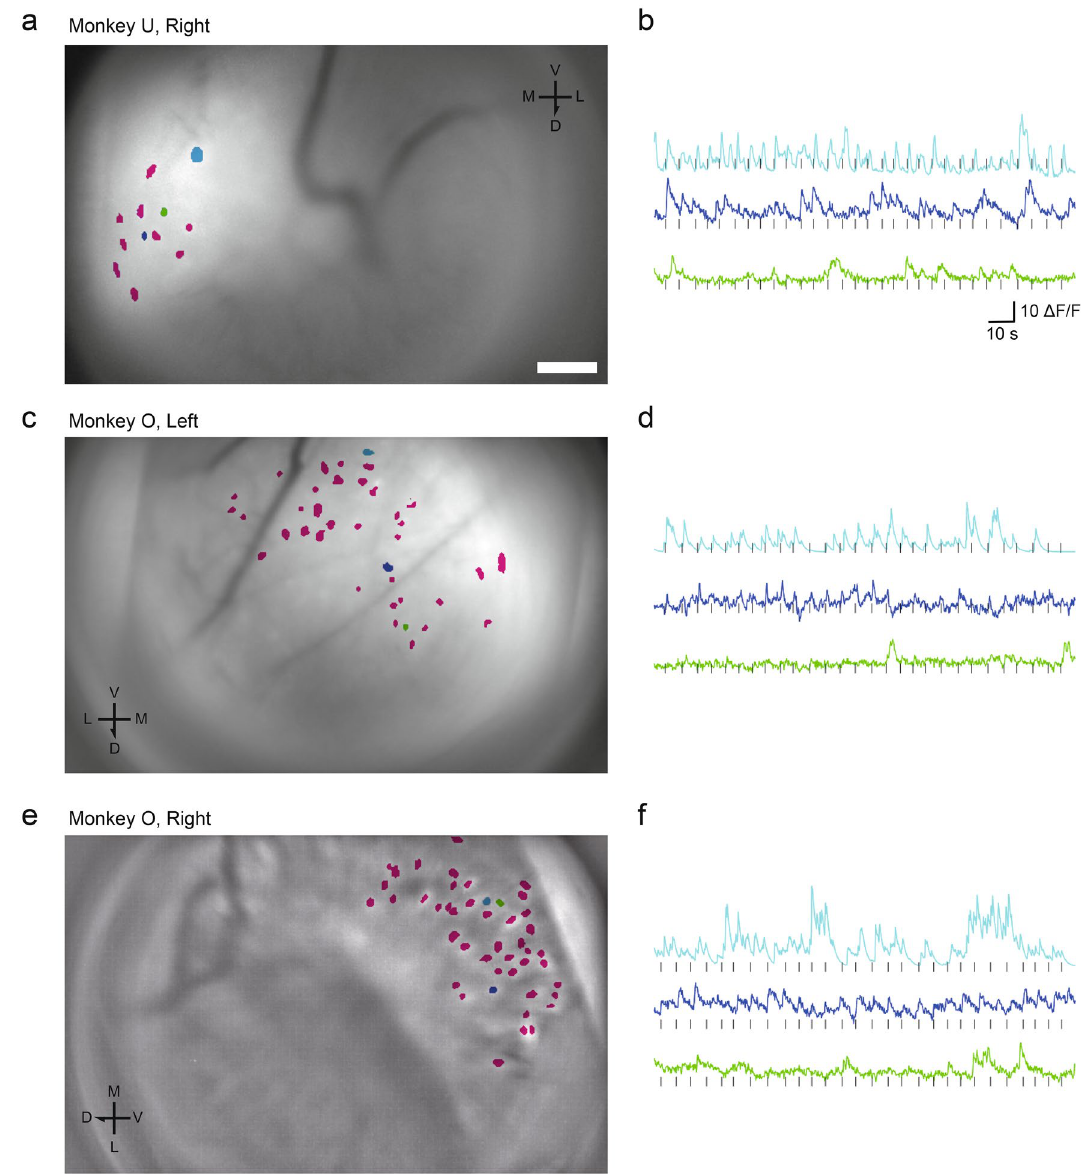
Figure 5. ROI detection and orientation tuning. ( a ) Colored dots indicate ROIs (putative neurons) detected from an imaging data recorded from the right hemisphere of monkey U. The background image is a Z projection using the maximum intensity of the imaging data. Scale bar: 100 µm. ( b ) Examples of time-series data of normalized fluorescence signals. Each colored line corresponds to ROIs filled with similar color in ( a ). Short black vertical lines represent timings of the stimulus onset. ( c – f ) The corresponding figures to ( a ) and ( b ) for the imaging data recorded from the left and right hemispheres of Monkey O. V, ventral; D, dorsal; M, medial; L,